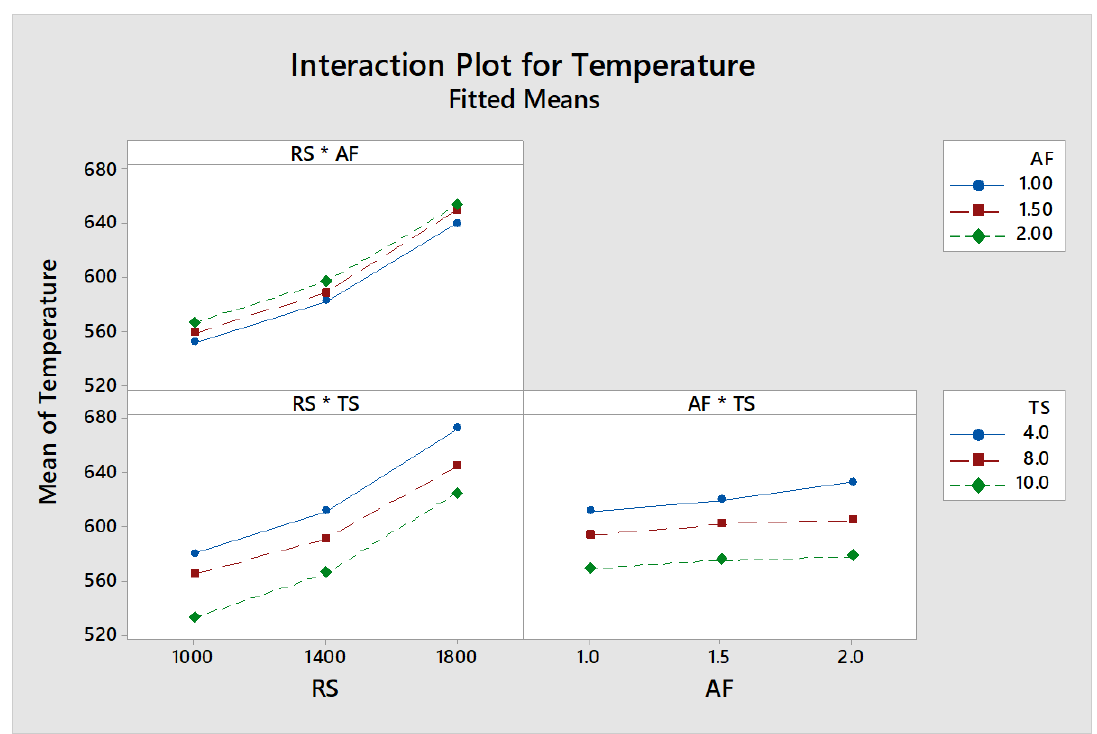
Figure 30. Interaction effect plot — temperature.